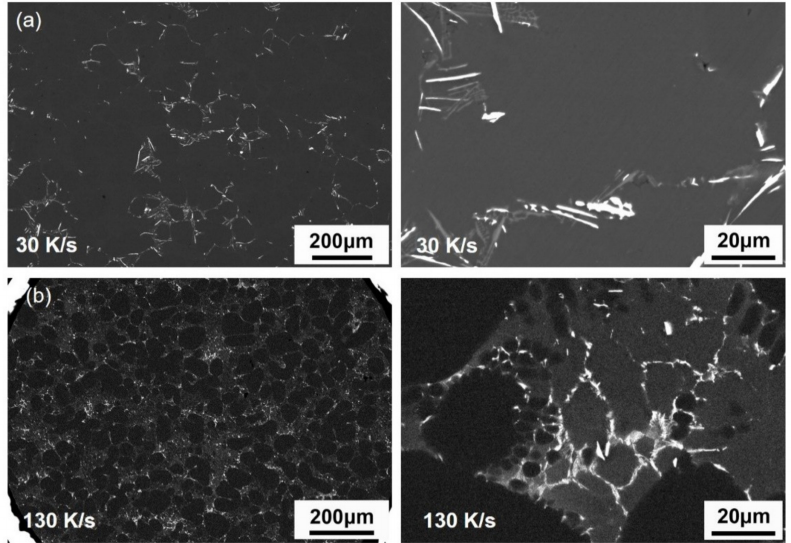
Figure 12. SEM microstructure showing the morphology of La-rich phases. ( a ) 30, ( b ) 130 K /